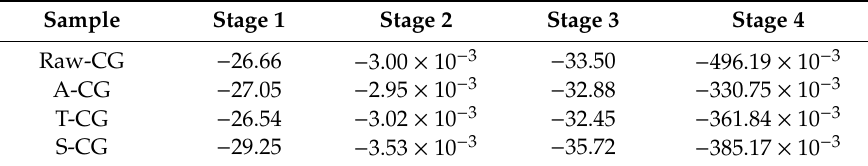
Table 6. Maximum excess pore water pressure / kN m − 2 .